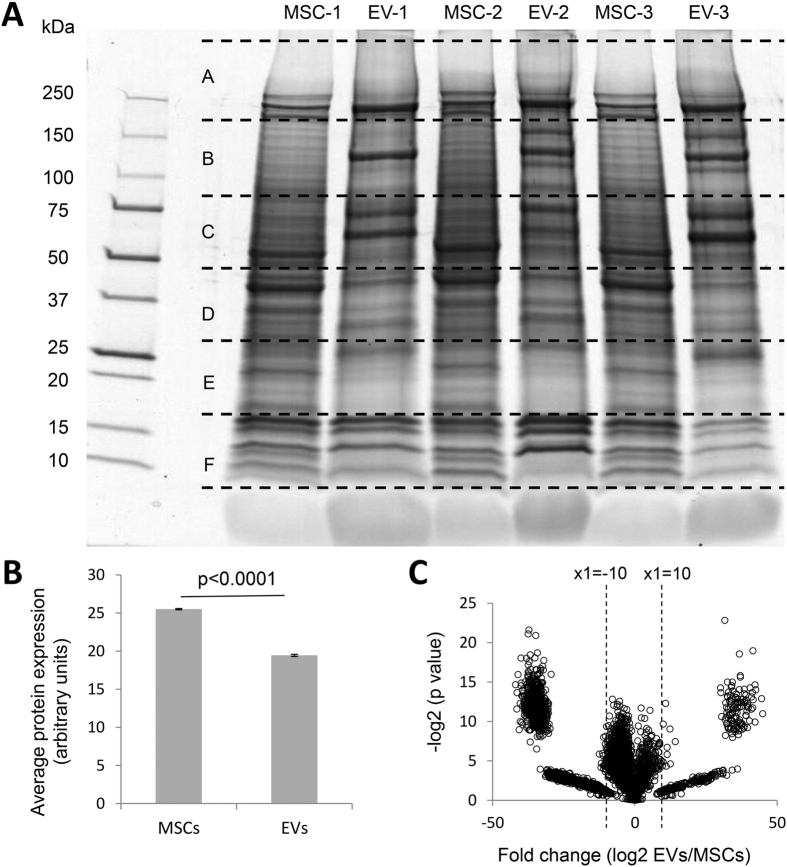
(A) Master gel for LC-MS/MS proteomic analysis of 3 MSC and 3 EV samples. The gel shows the relative molecular weight on the left side. Slices were labeled (A–F) with A being at the highest molecular mass >250 kDa and F being the lowest (10–15 kDa). (B) Average protein expression was higher in MSCs compared to EVs. (C) Volcano plot of identified proteins in MSCs and EVs.